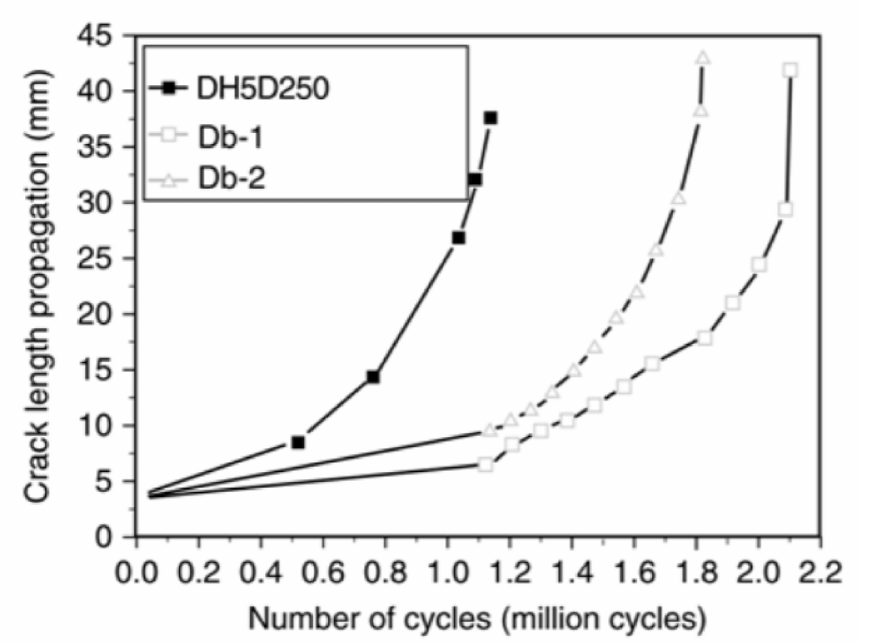
Figure 11. Fatigue life curve of specimens with a completely covered initial crack with normal modulus CFRP [128], with permission from 2021 Composite Structures, Elsevier, UHM CFRP [54], with permission from Advances in Structural Engineering, SAGE,